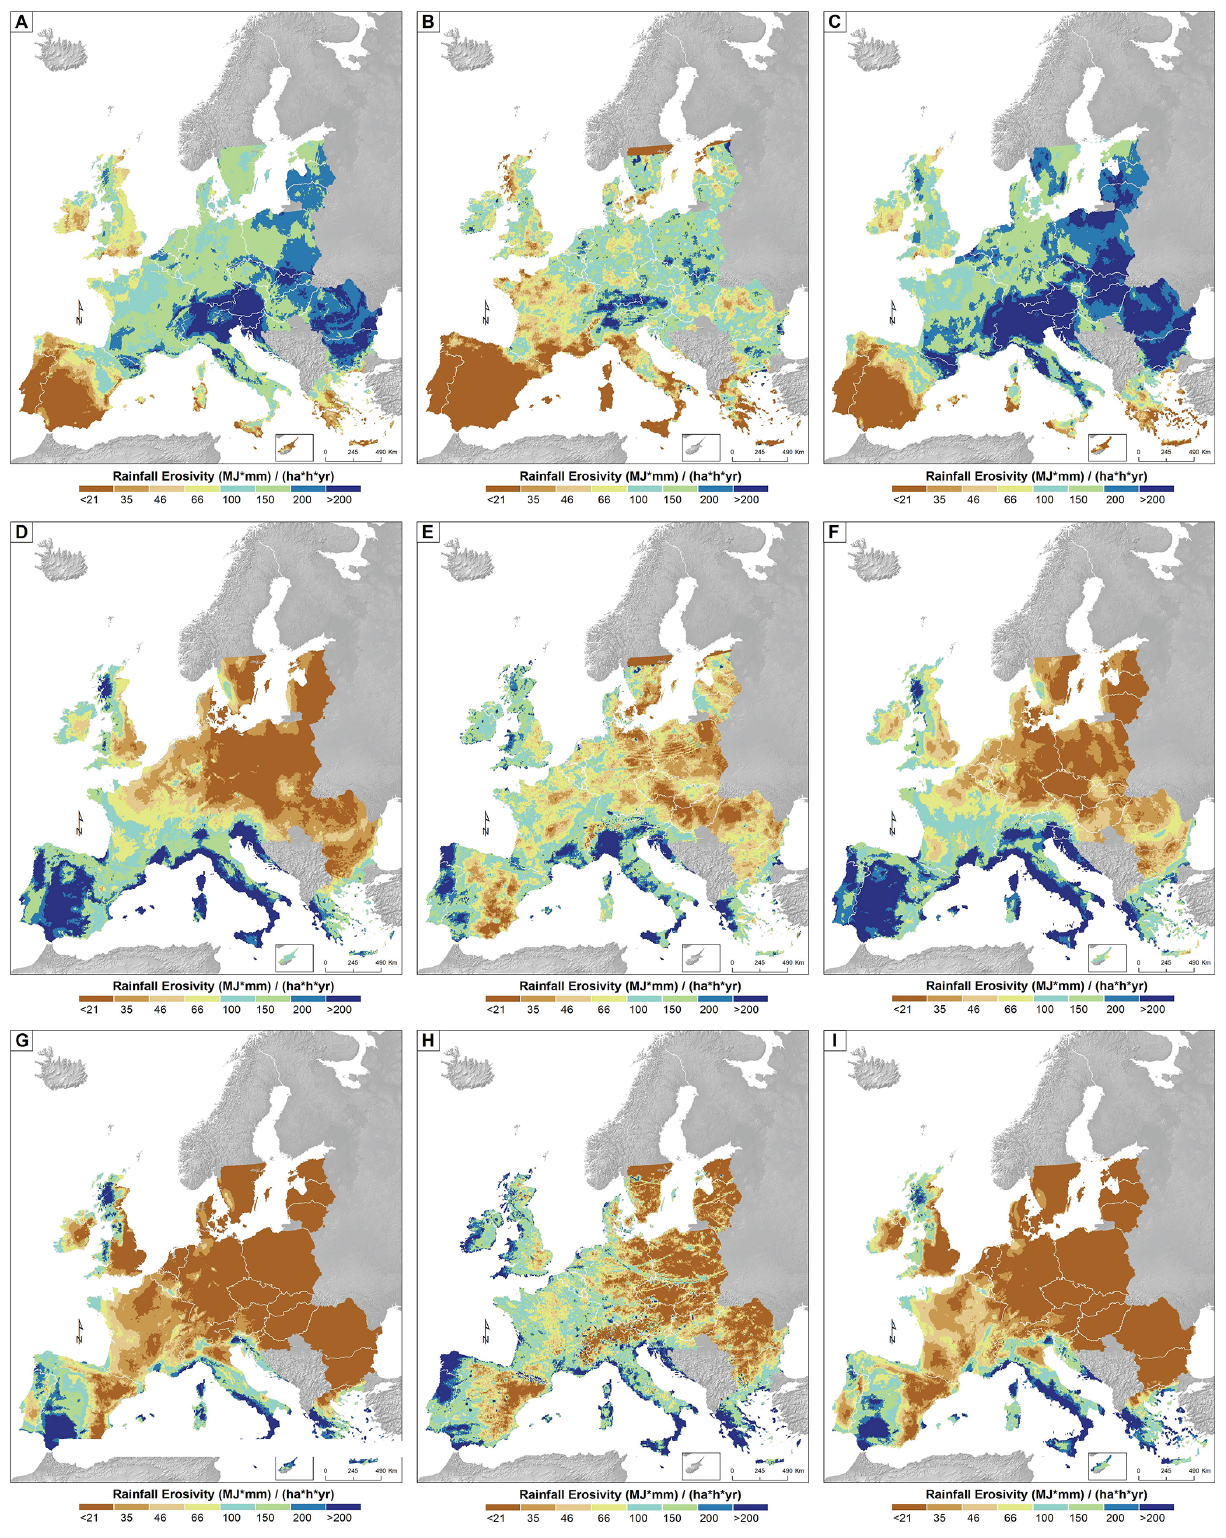
Figure 7. Comparison between monthly erosivity maps for Europe prepared by the Ballabio et al. (2017) (a, d, g) , CMORPH (b, e, h) , and ED concept (c, f, i) maps for July (a, b, c) , October (d, e, f) , and December (g, h, i)